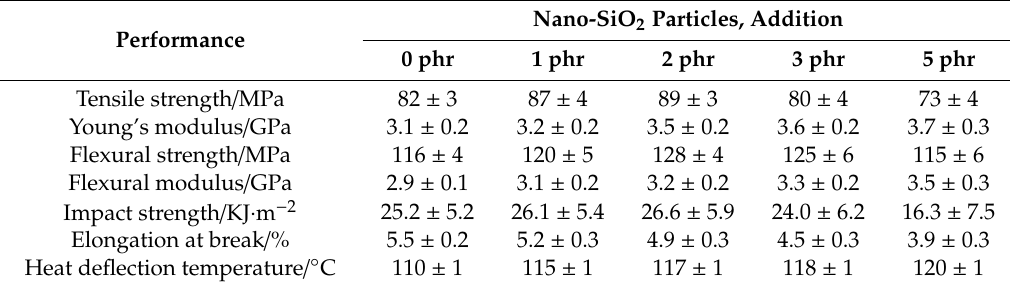
Table 4. Test results of nano-SiO 2 particles modified epoxy resin (with 10 phr CSR).